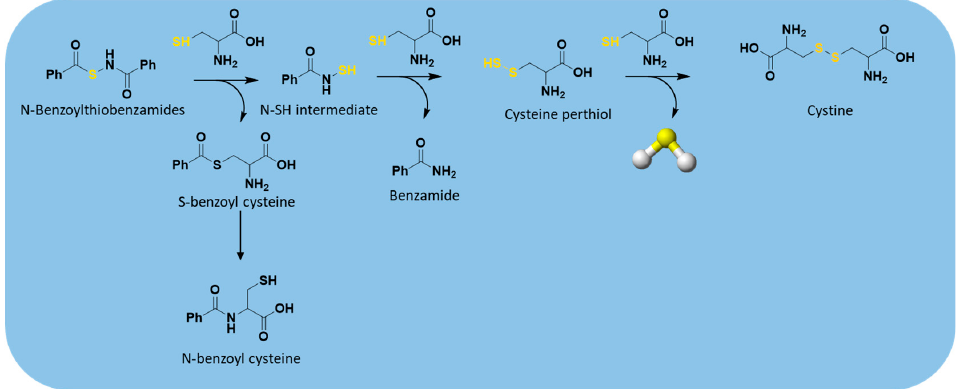
Figure 9. H 2 S release from N-benzoylthiobenzamides.